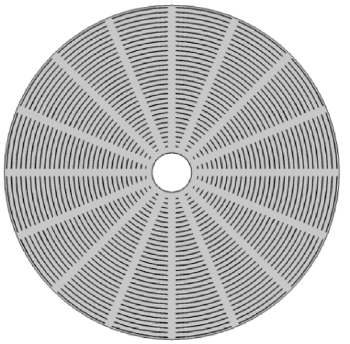
Fig. 6. Proposed design for metamaterial using PTFE- fi lled cuts in a copper cylinder.